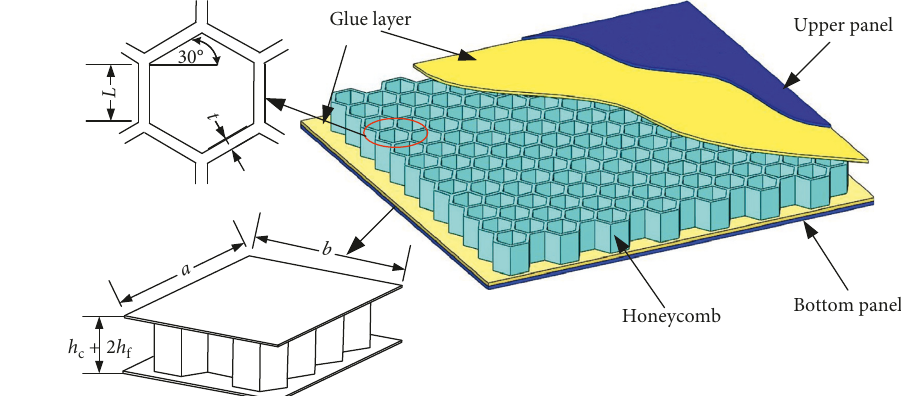
Figure 1: Honeycomb sandwich panel structure.